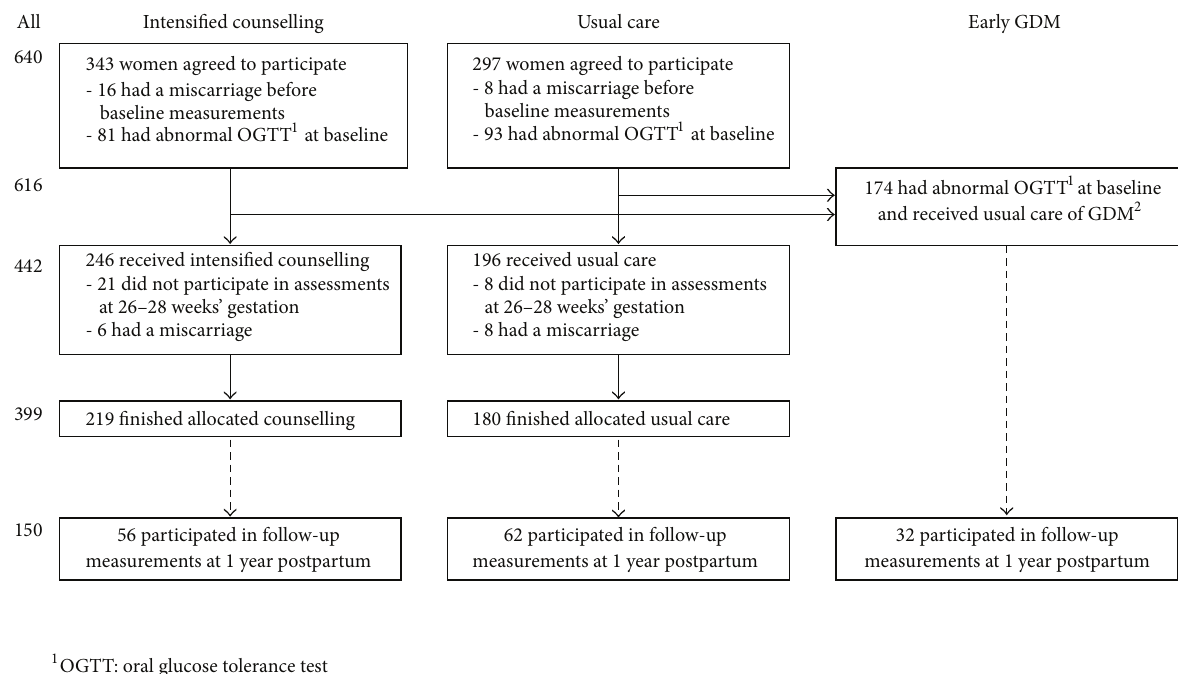
Figure 1: Flow diagram of the study, ending in followup assessments at one year postpartum. The two intervention groups (intensified counsellingandusualcare)andthosewithGDMdiagnosedatearlypregnancy(8–12weeks’gestation)wereinvitedforfollowupmeasurements at one year